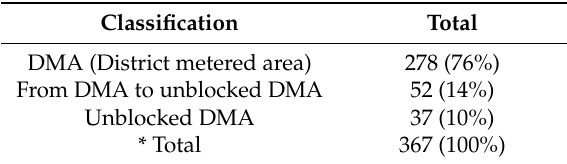
Table 2. Status of Incheon’s